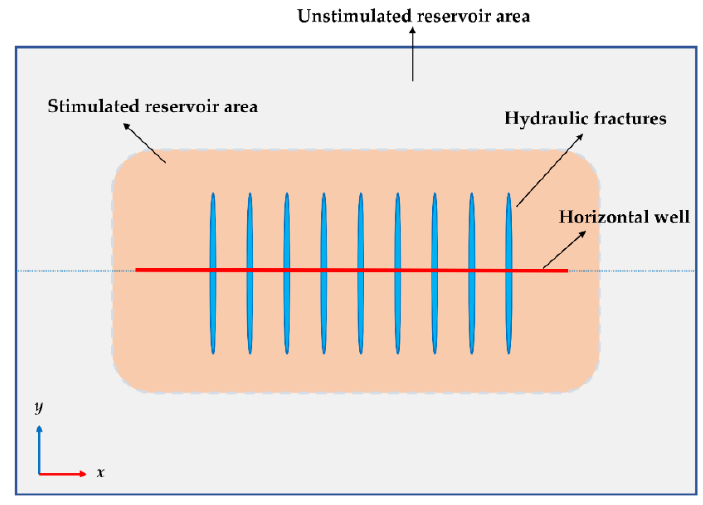
Figure 3. The diagram of shale oil reservoir with a multistage fracturing horizontal well.